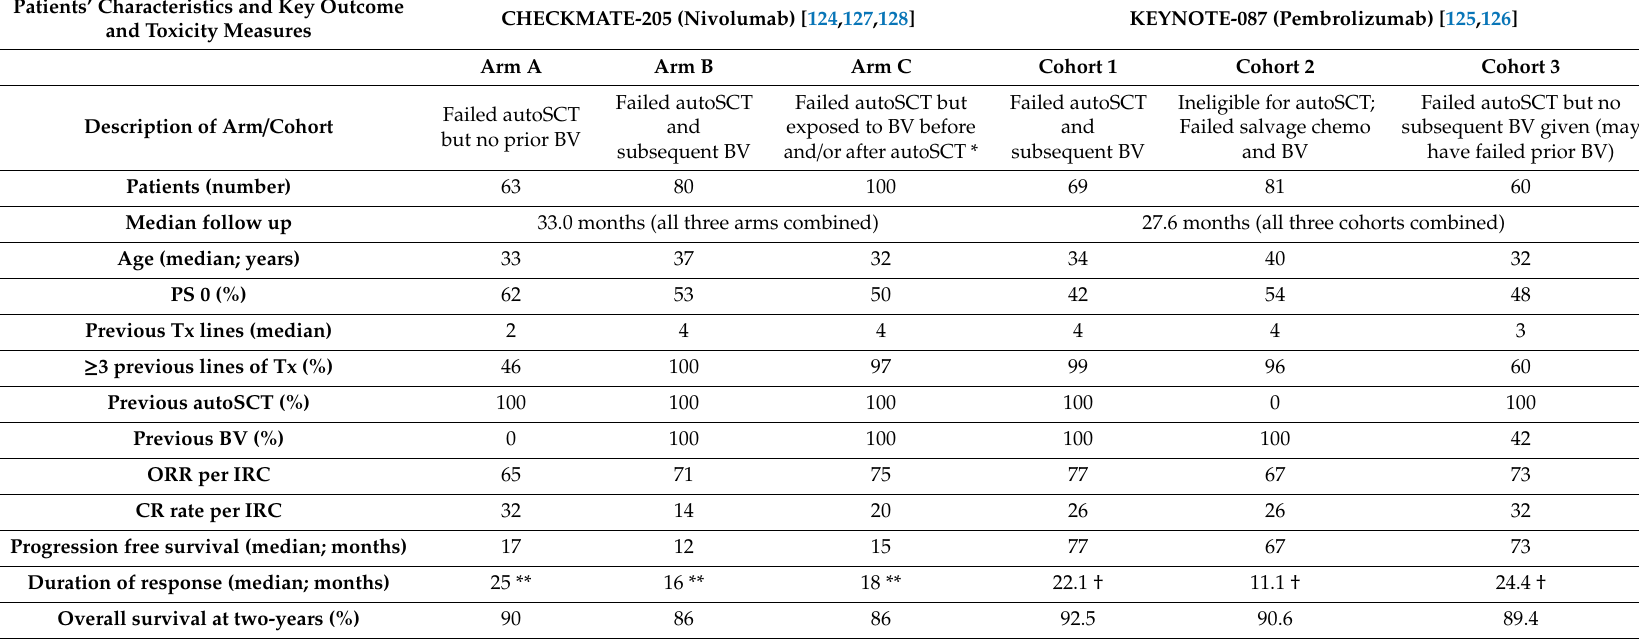
Table 9. Patients’ characteristics and outcomes of Checkmate 205 and KEYNOTE-087 trials of nivolumab and pembrolizumab, respectively, by arm / cohort. Patients’ Characteristics and Key Outcome and Toxicity